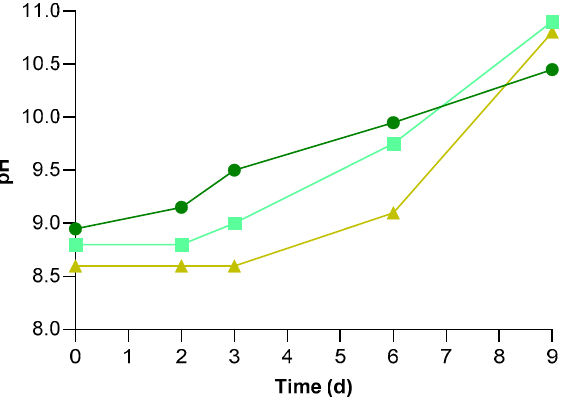
Figure 4. pH variation (average ± standard deviation) over time (d) for each PBR: (cid:4) CV ( C. vulgaris + UWW); (cid:4) C+ ( C. vulgaris + autoclaved UWW); and (cid:4) C − (raw UWW).